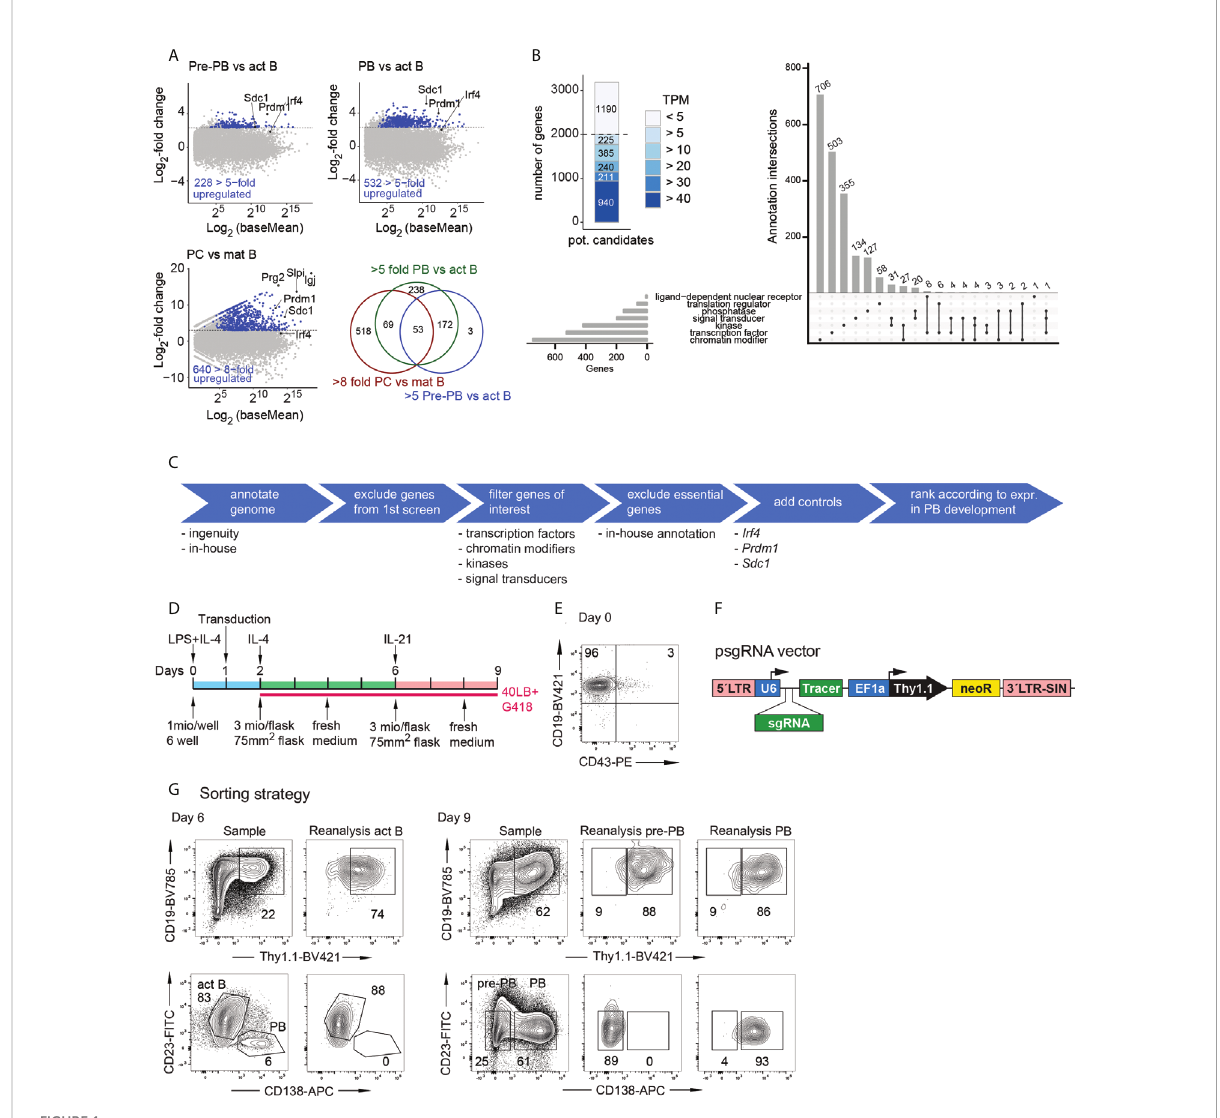
FIGURE 1 Experimental setup of the screens. (A) M/A blots depicting the overview of the genes which were chosen for screen 1. Data from RNA-Seq of iGB derived act B cells (CD19 + Blimp1 – CD138 – ), pre-PB (CD19 + Blimp1 + CD138 – ), or PB (CD19 + Blimp1 + CD138 + ) from Blimp1 Gfp/+ mice. Chosen genes had to be at least 5-fold upregulated in the act B vs pre-PBs or act B vs PBs comparison (top row). RNA-Seq of PCs and mature B cells, depicted are genes which are 8-fold upregulated (10) (bottom row left). Overlap of the genes of the 3 M/A blots (bottom row right). (B) Overview of the genes of screen 2. Genes were selected by the criteria in (C) and grouped by their expression. Genes which did not reach an expression of at least 5 transcripts per million (TPM) in the act B, pre-PBs or PBs were discarded (left blot). The remaining genes fall into the depicted categories (Upset blot). (D) Timeline of the iGB culture for the screens. The cells were transduced on day 1, seeded on 40LB cells on day 2 und 6 and G418 was added from day 2 on. (E) Flow cytometric analysis of the splenic B cells after magnetic cell enrichment. (F) Structure of the psgRNA-U6-Thy1.1 vector. LTR= long terminal repeat, U6 = U6 promotor, sgRNA = single guide RNA, Tracer = tracer sequence, used for the pooled sequencing of the screen, EF1a = EF1a promoter, neoR = neomycin resistance. (G) Flow cytometric sorting of the cells of screen 2 on day 6 (left) or day 9 (right). The unsorted sample is shown and the reanalysis of the different populations after the cell